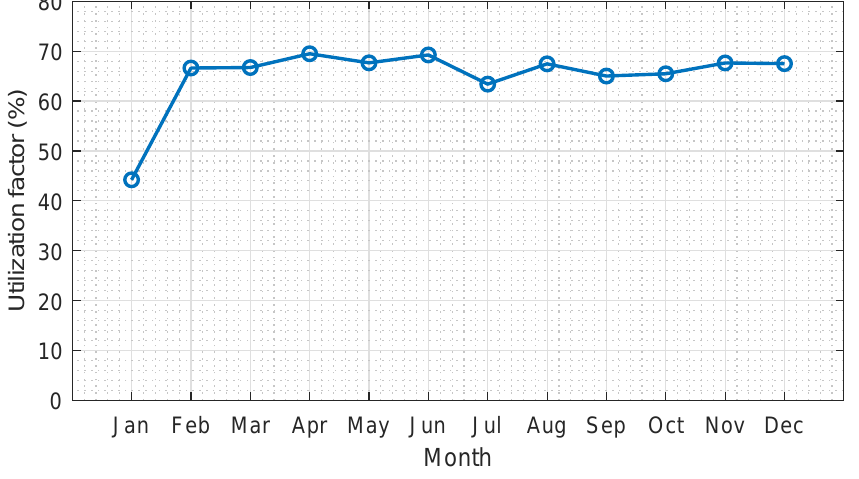
Figure 10. Variation of utilization factor by